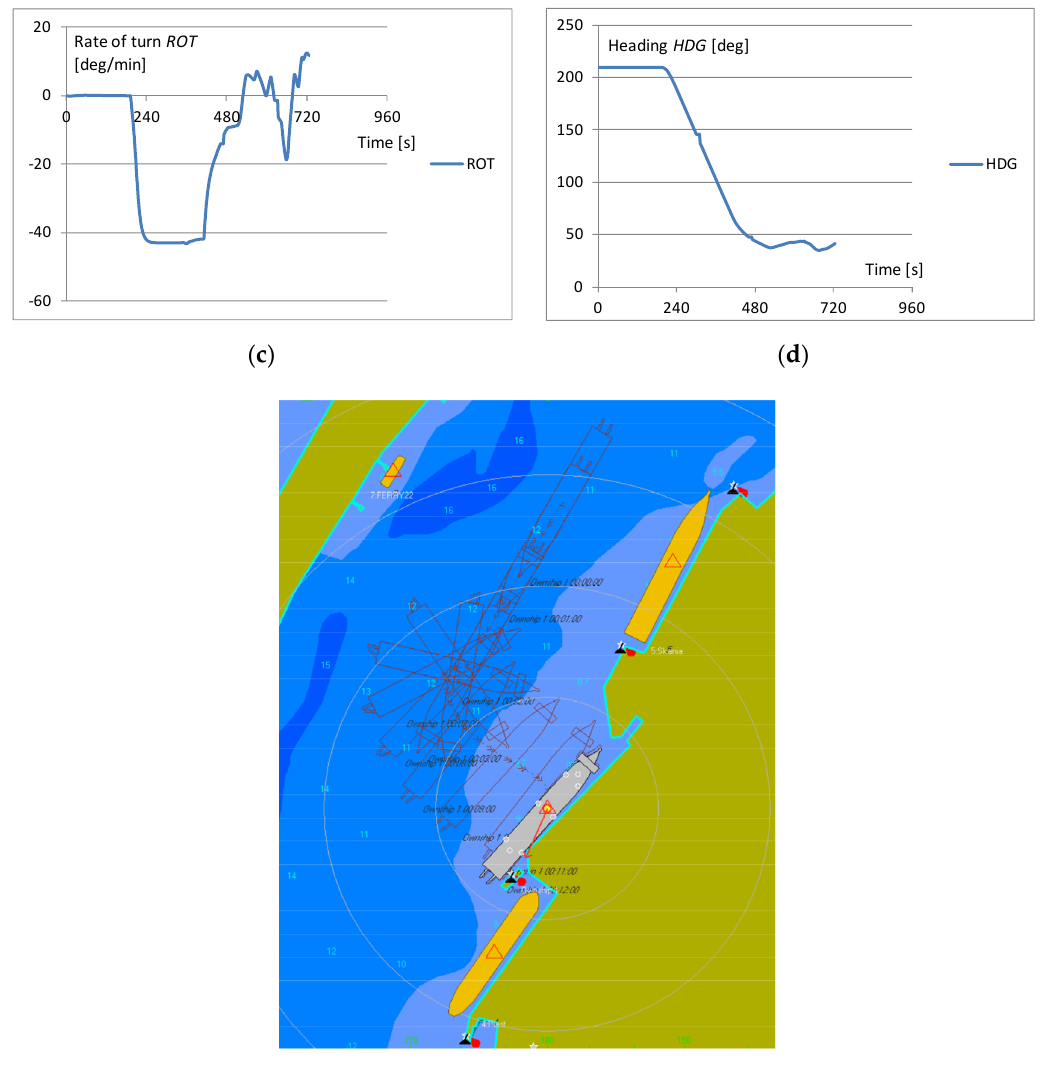
Figure 10. Representative time history of basic kinematic parameters of ferry test manoeuvre—independent steering case only (‘ind #3’): ( a ) surge velocity (kn); ( b ) sway velocity (kn); ( c ) rate of turn (ROT, yaw velocity) ( ◦ /min); ( d ) heading ( ◦ ); ( e ) ship’s track (swept path) view at the instructor’s display.